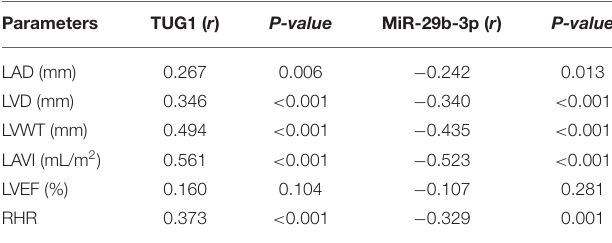
TABLE 2 | Correlation of TUG1 and miR-29b-3p with various indicators